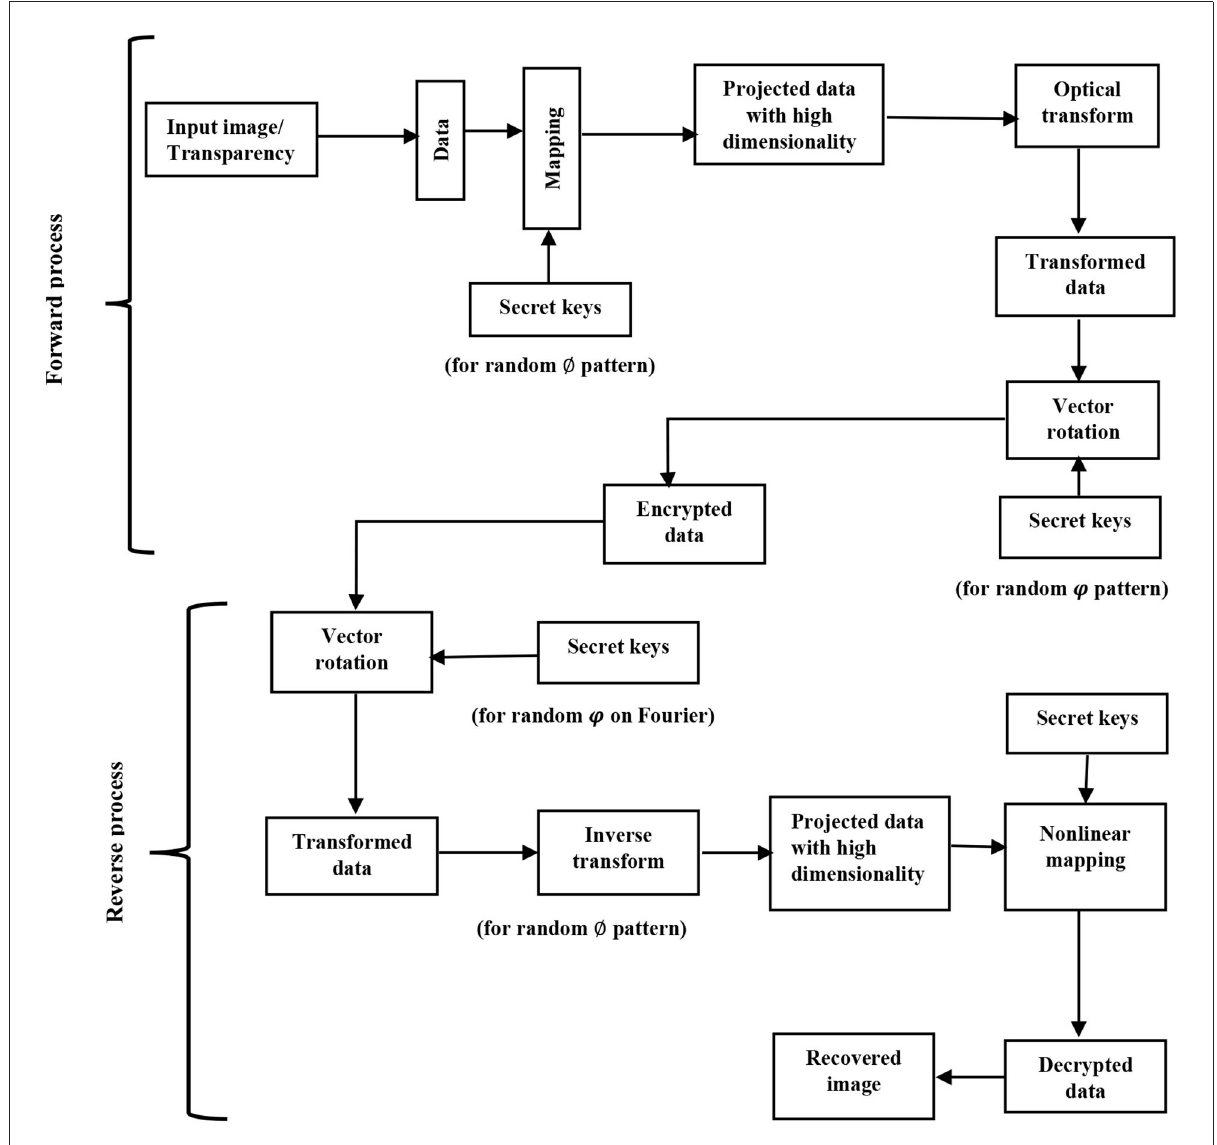
FIGURE2 Architectural model for DRPE-based encryption